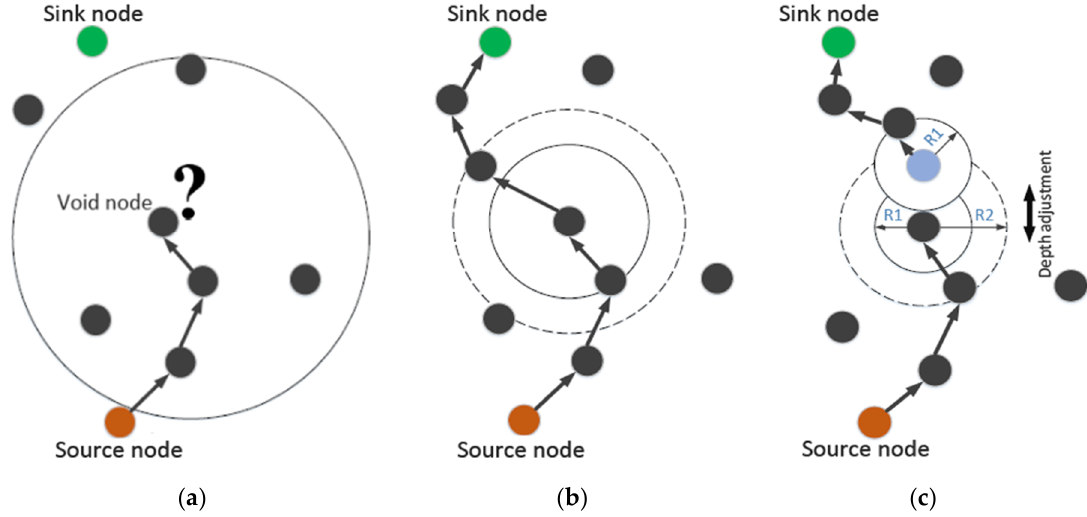
Figure 20. ( a ) void area, ( b ) Adjustment of transmission Power, ( c ) Adjustment of depth.